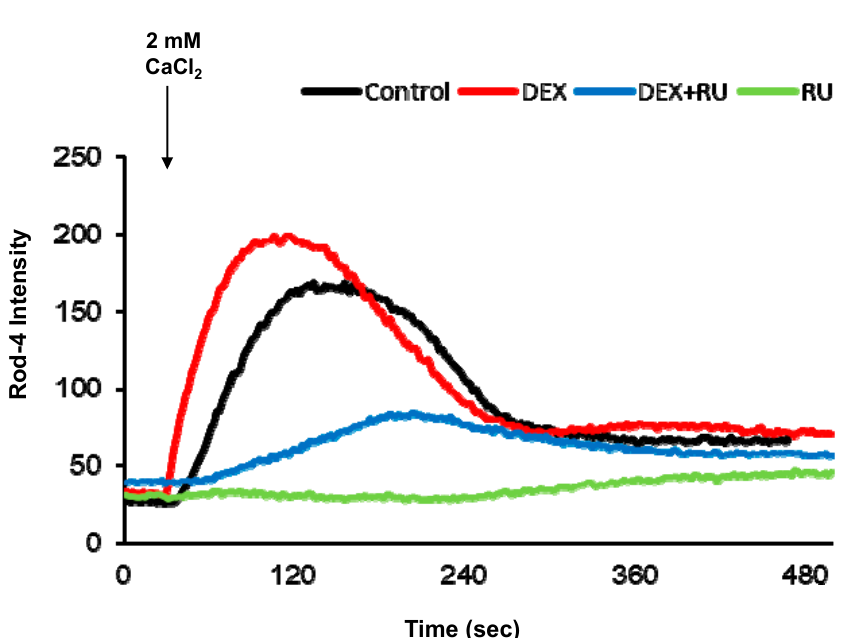
Figure 2. Intracellular calcium response a ff ected by dexamethasone. Intracellular calcium response was increased by DEX at 24 h after attachment. DEX and a glucocorticoid receptor antagonist RU486 a ff ected intracellular calcium response. Comparison of intracellular calcium response determined by confocal microscopy. DEX, 10 − 8 M of dexamethasone; DEX + RU, 10 − 8 M of dexamethasone treated with 10 − 6 M of RU486; RU, 10 − 6 M of RU486.